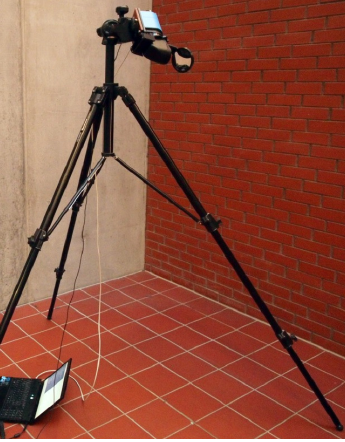
Figure 7. Practical test – scanner mounted on